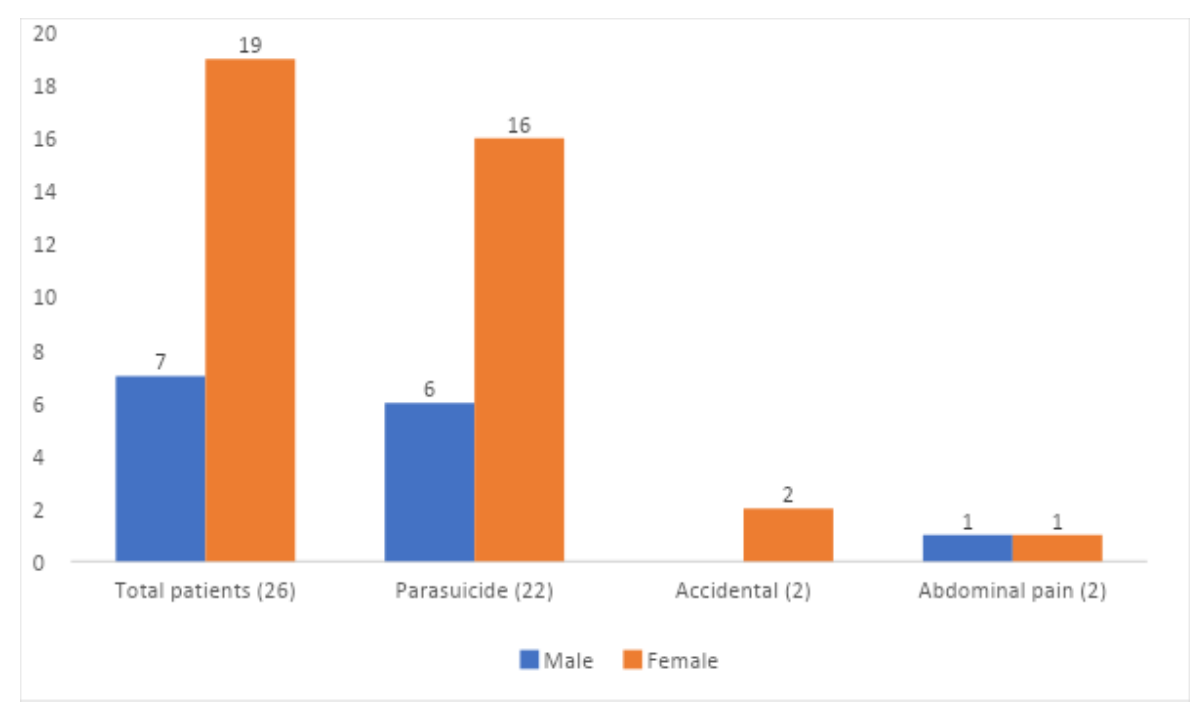
Figure 1. Reason for KMnO 4 Ingestion.